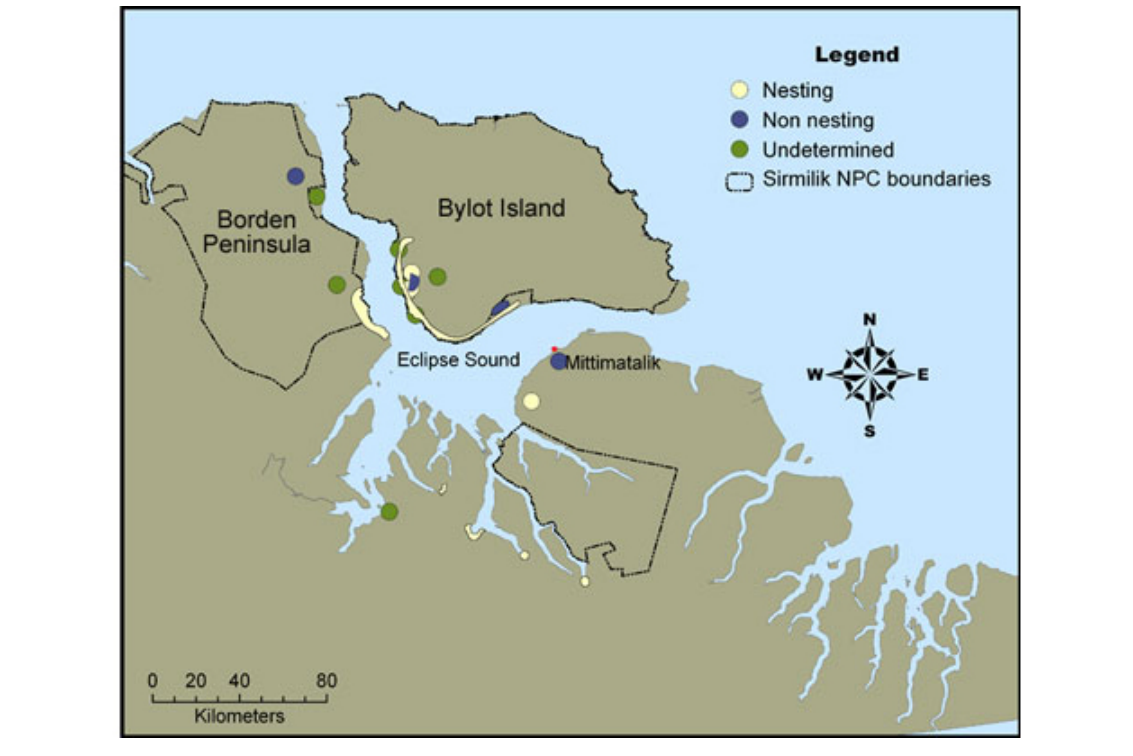
Fig. 5 . Molting locations for nesting and non-nesting greater snow geese ( Chen caerulescens atlantica ), as reported by the local experts from Mittimatalik, Nunavut, Canada, interviewed in this study. Informants did not specify the breeding status (nesting, non-nesting, or both) of molting geese encountered on locations marked as